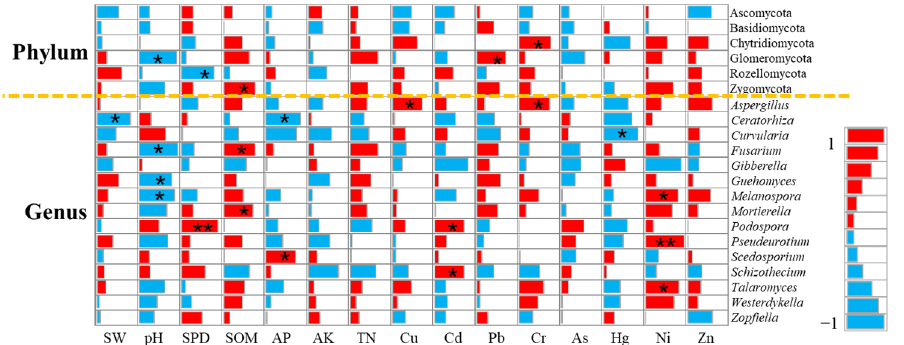
Figure 14. Correlation between soil environmental factors and fungal community structure at low levels of heavy metal pollution. (Note: In the figure, warm colors indicate positive correlation, and cool colors indicate negative correlation. *, ** ndicate significant correlation at the levels of 0.05, 0.01, and 0.001, respectively).